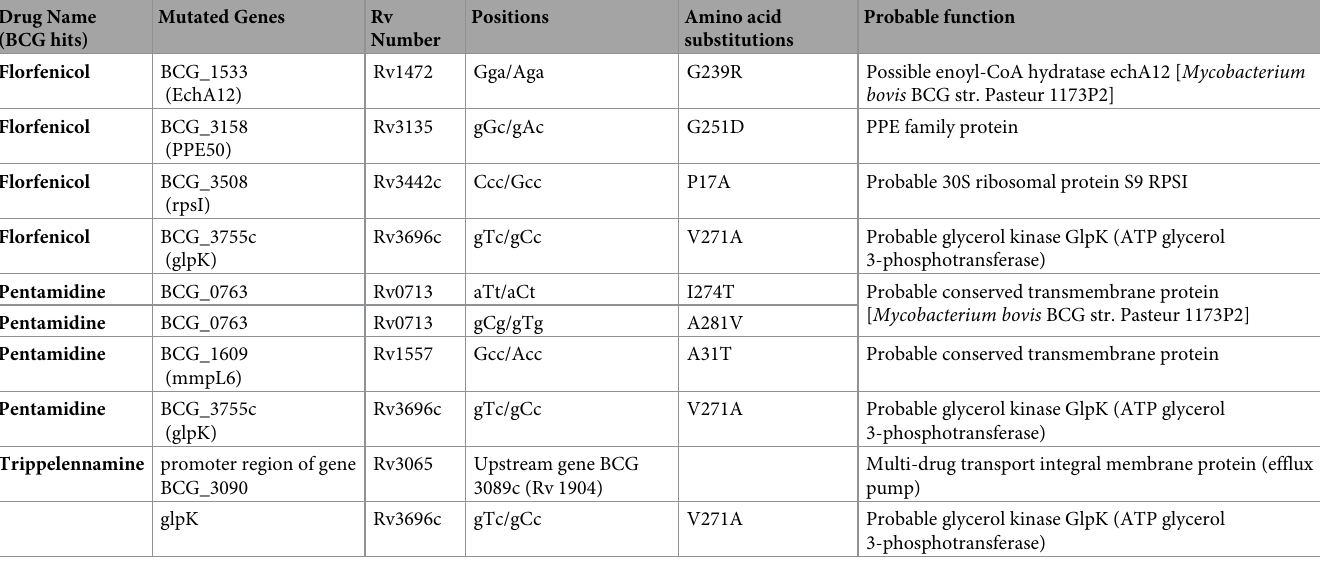
The table represents the single nucleotide polymorphisms obtained through whole genome sequencing of the spontaneous resistant mutants raised compared against drug sensitive